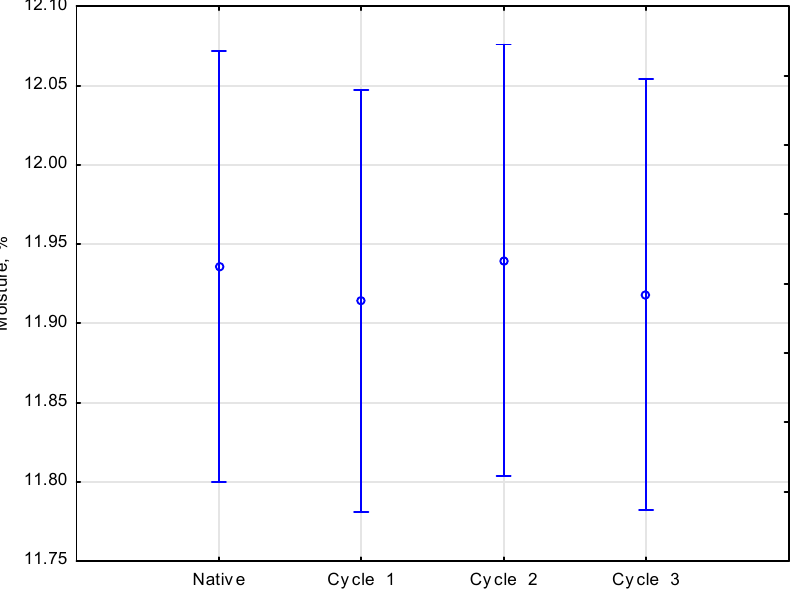
Figure 3. E ff ect of the number of salinated water soaking cycles applied on wood moisture. Figure 3. Effect of the number of salinated water soaking cycles applied on wood